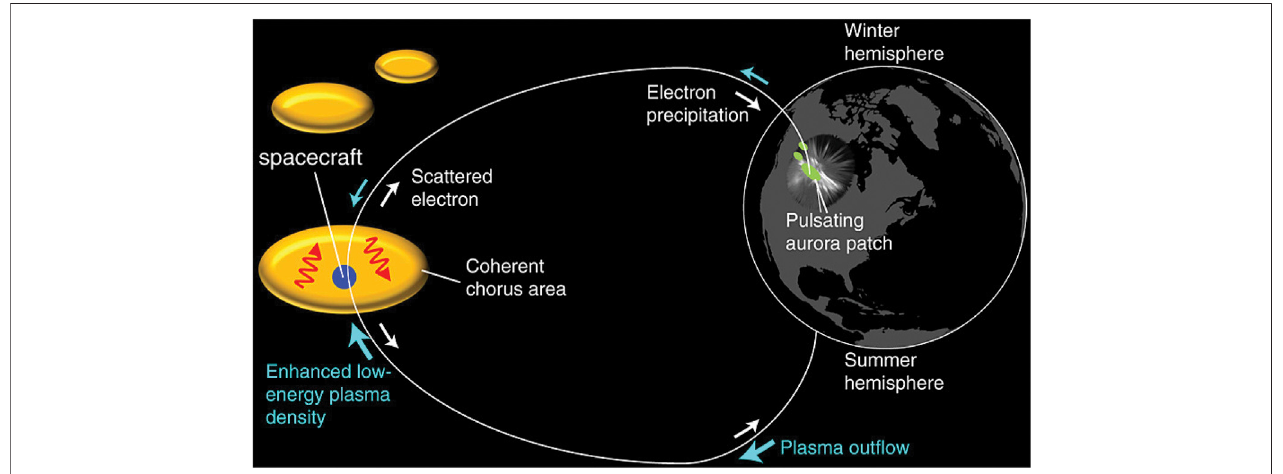
FIGURE 1 | Schematic illustration of the formation of cold plasma fl ux tubes from ionospheric out fl ows and its connection to PPA. Copied from Nishimura et al. (2015).